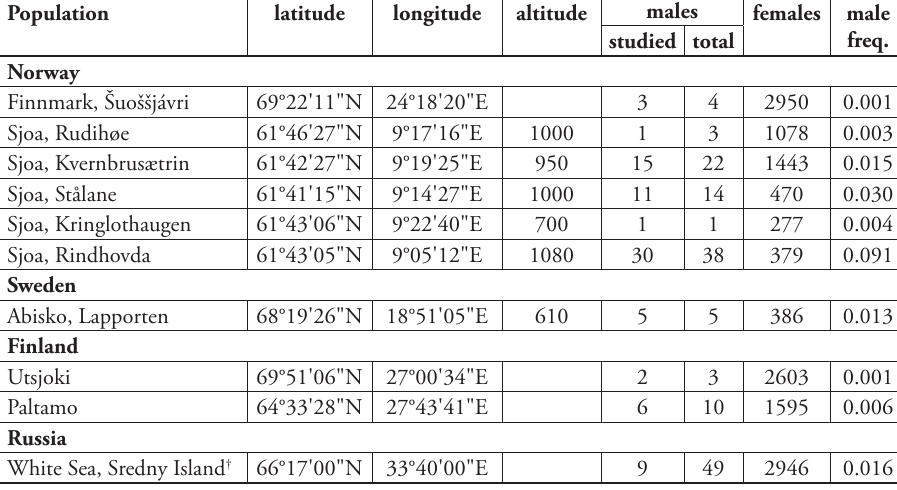
table 1. Locations of C. myrtilli populations in Norway, Sweden, Finland and Russia. Number of cyto- logically studied males, total number of males, number of females and frequency of males. Population latitude longitude altitude males females male freq.studied